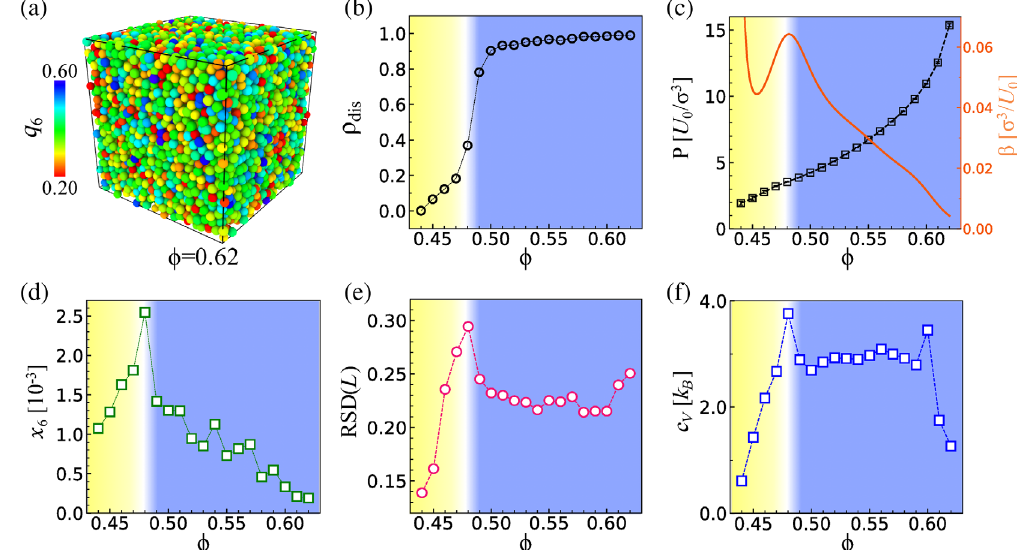
FIG. 9. The compression-induced crystal-glass transition in 3D. (a) The completely disordered glass state at ϕ ¼ 0 . 62 colored with weighted bond-orientational order q 6 . (b) The fraction of disordered particles. (c) The EOS P ð ϕ Þ and compressibility β . (d) Susceptibility χ 6 of the 3D orientational order. (e) Relative standard deviation of ( L ). (f) The residual specific heat c V .